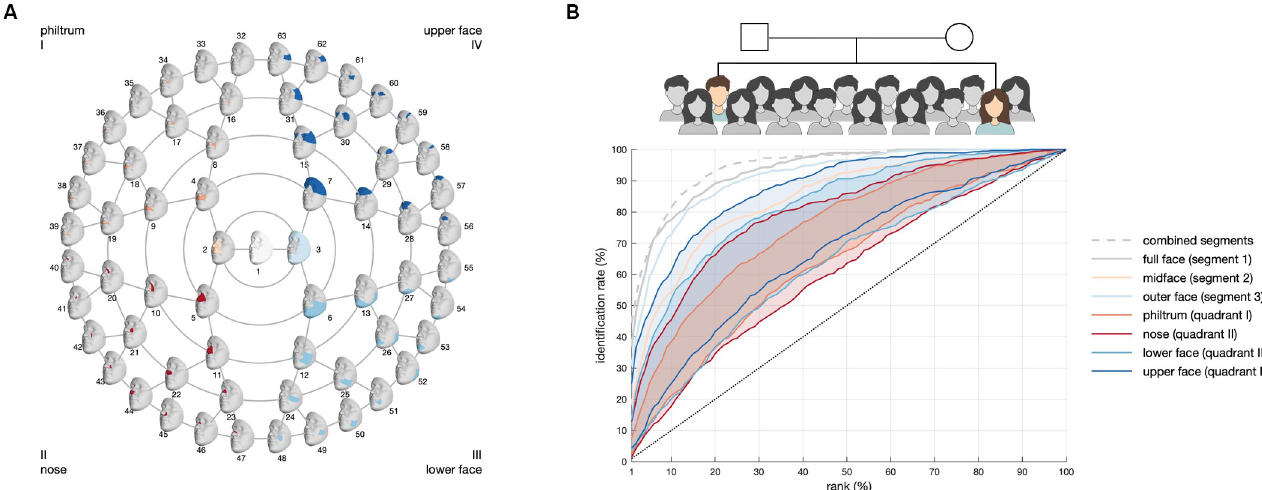
Fig 2. Global-to-local matching of siblings. (A) Global-to-local segmentation of 3D facial shape obtained using hierarchical spectral clustering of the EURO cohort. Segments are colored per quadrant, represented by the roman numerals. (B) Phenotypically similar sibling pairs were identified in a biometric identification setup, which involves the comparison of facial shape between siblings and with unrelated individuals. Matching performance using different similarity measures and facial features was evaluated using cumulative match characteristic (CMC) curves. Plotted is the percentage of sibling pairs that were correctly identified (y-axis) within the top-k% matches (x-axis) using the Mahalanobis angle. Curves are colored based on the facial features that were used to match siblings. For each quadrant, the highest and lowest identification rates per rank are shown, with the area between the two shaded.